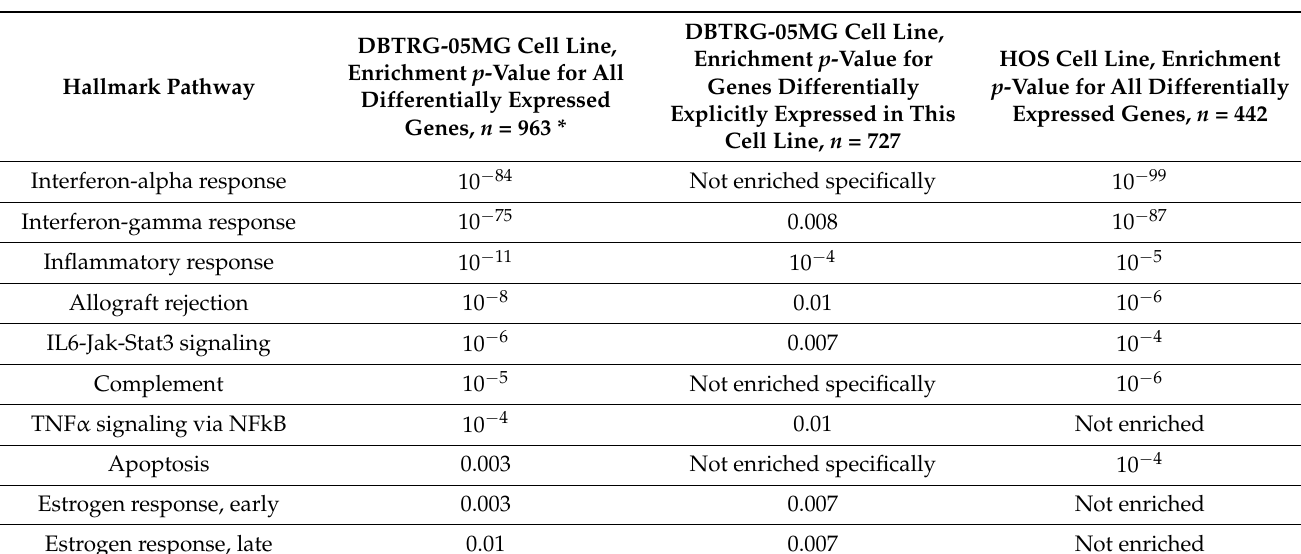
Table 1. Hallmark molecular pathways as composed by Molecular Signatures Database [27] enriched in differentially expressed genes after interferon α 2 β treatment of DBTRG-05MG and HOS cell lines.